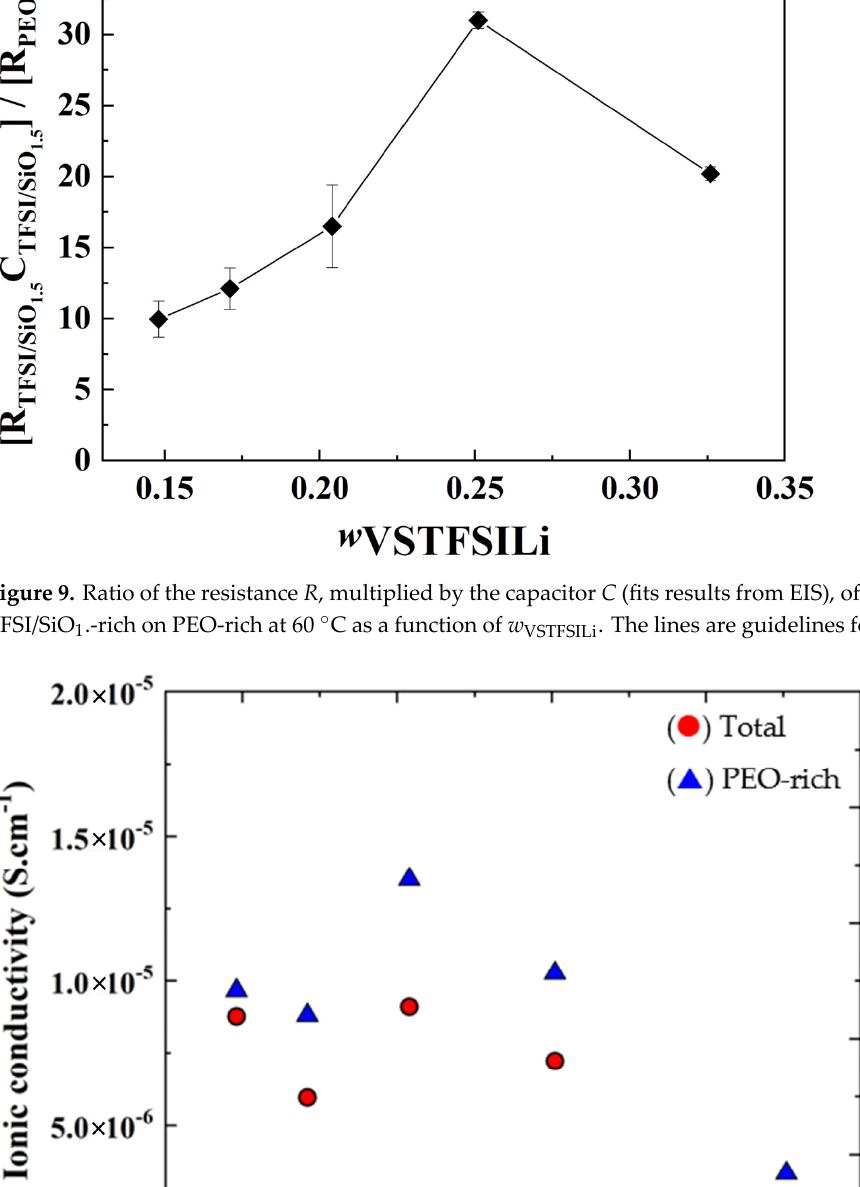
Figure 8. Ionic conductivity of the PEO-rich as a function of the inverse of the temperature for HySI_ w VSTFSILi electrolytes. The lines correspond to the VTF fits.